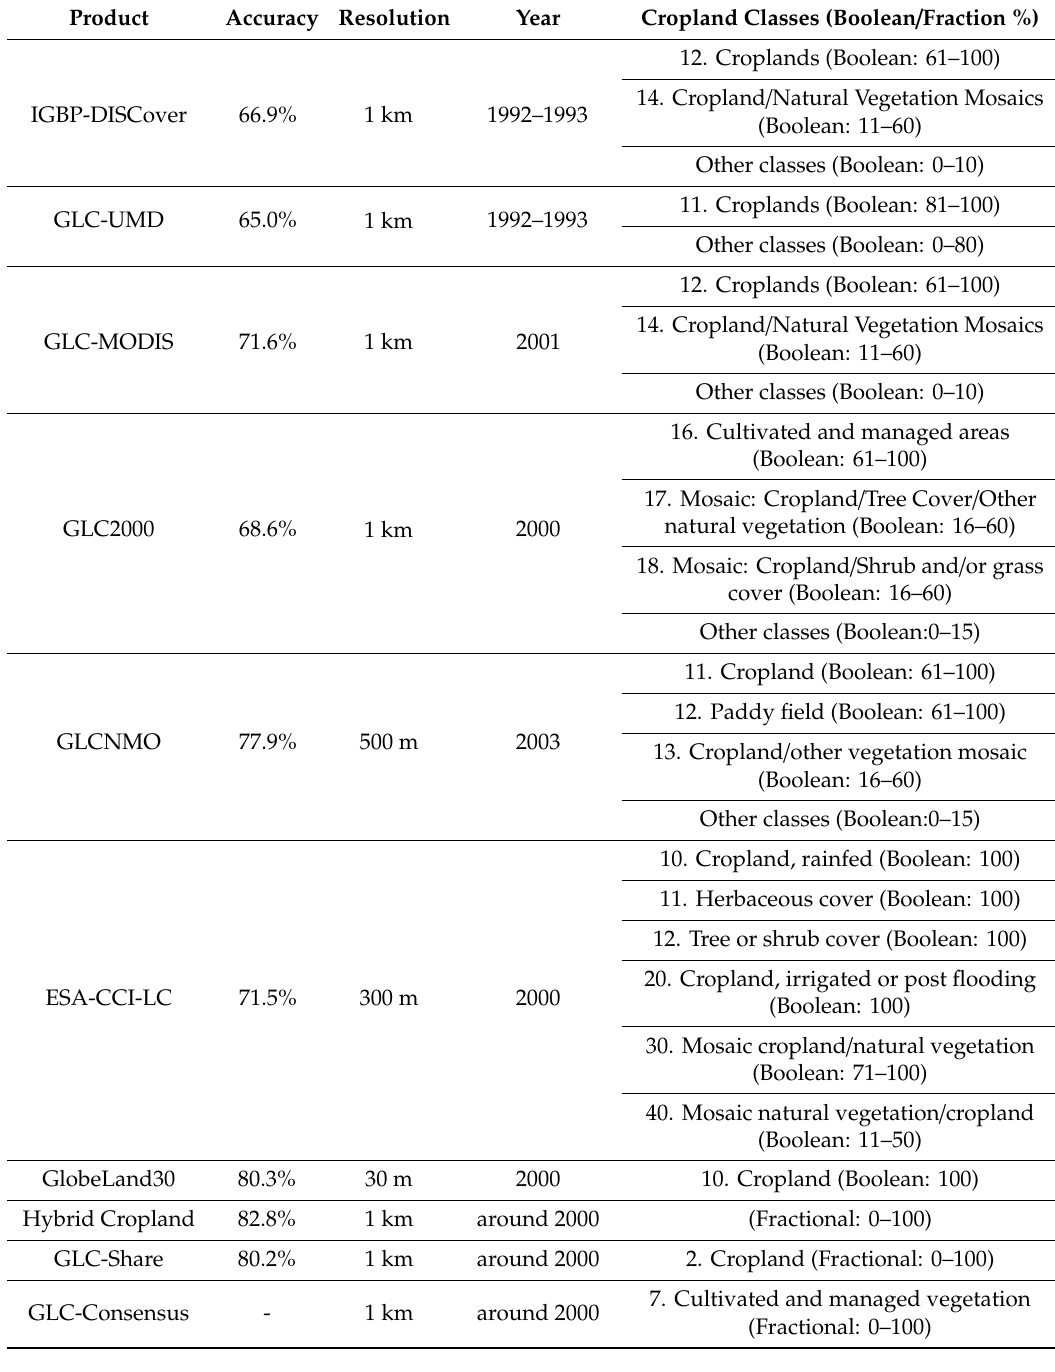
Table 1. The cropland-related information in 10 global land cover products / synergized